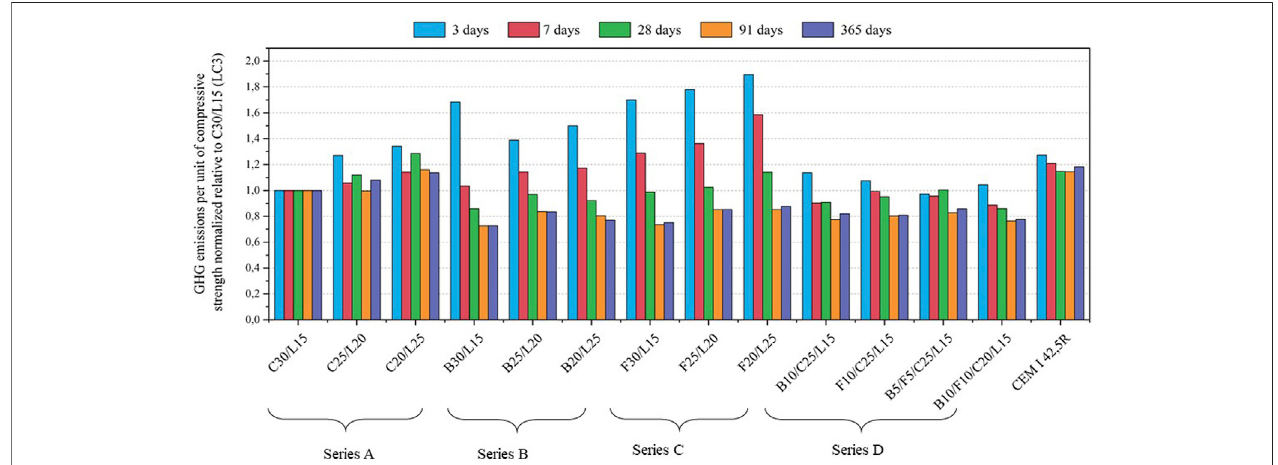
FIGURE 6 | GHG emissions per unit of compressive strength normalized relative to C30/L15 (LC 3 ) at 3, 7, 28, 91 and 365